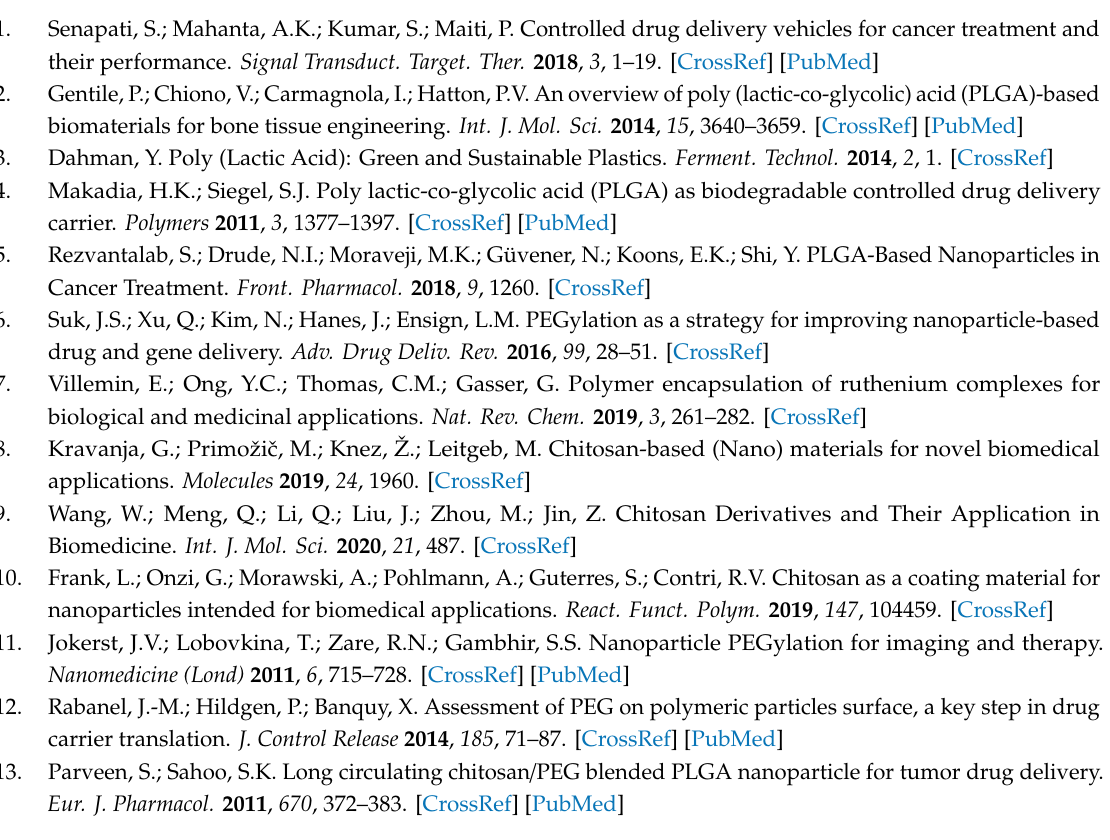
Table S1: Size and dispersity data for formulations prepared by the solvent evaporation method. Table S2: Mean particle size, dispersity and zeta potential data for formulations with varying flow rate ratios and total flow rates. Figure S1(A): Representative zeta potential plots showing surface charge variation with increasing % PEG coating density of solvent evaporation (bulk) prepared formulations; Figure S1(B): Representative zeta potential plots showing surface charge variation with increasing % PEG coating density of microfluidics (nano) prepared formulations. Figure S2: XRD spectra of the starting materials, blank and loaded nanoparticles (6% PEG) prepared by microfluidic (nano) and solvent evaporation (bulk) methods. Disulfiram is expressed as